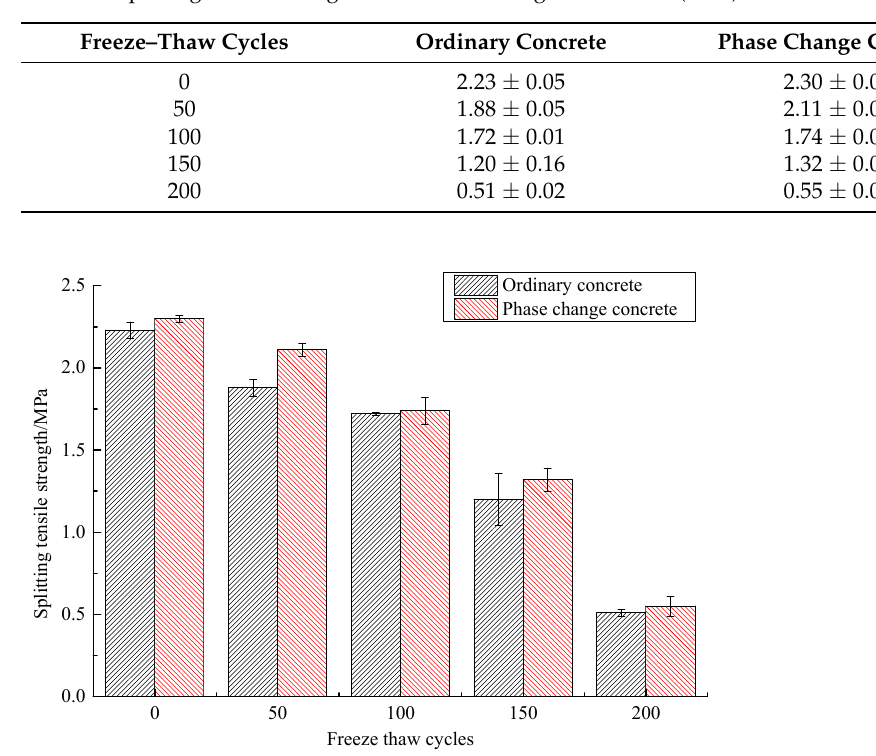
Table 13. Splitting tensile strength of concrete during freeze–thaw (MPa).